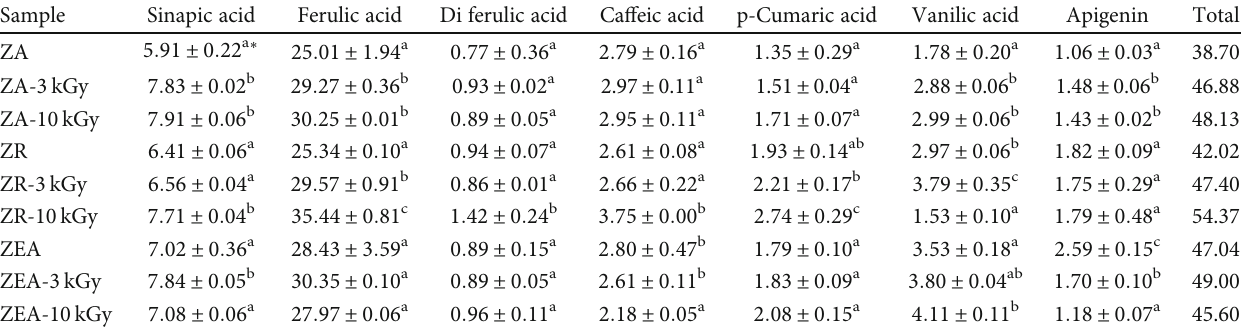
Table 1: The content of the selected polyphenols in rye grains before and after irradiation [mg/100 gdm].